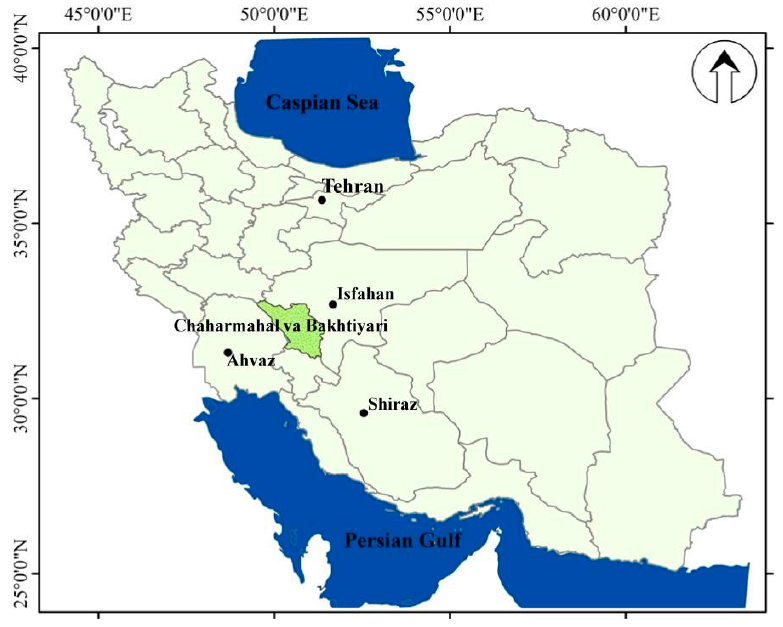
Figure 1. Location of study site, Chaharmahal va Bakhtiyari, Iran.